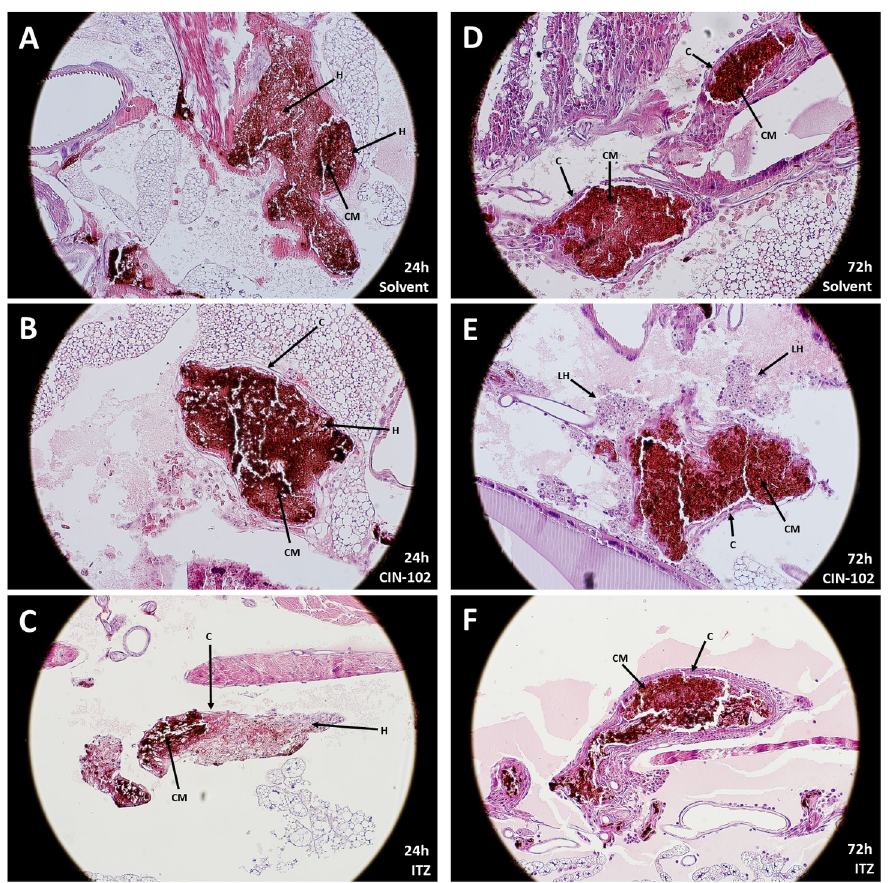
Fig 4. M . mycetomatis grains in Galleria mellonella larvae, 200x magnification. A: M . mycetomatis grain 24h after infection and treated with solvent. Cement material (CM) is present. No clear capsule is formed surrounding this grain. Some individual hemocytes (H) are present in the cement material. B: M . mycetomatis grain 24h after infection and treated with 80mg/kg CIN-102. Cement material is present. A capsule (C) is surrounding the grain, individual hemocytes are found in the grain. C: M . mycetomatis grain 24h after infection and treated with 5.71 mg/kg itraconazole (ITZ). Partial formation of cement material and encapsulation of the grain are observed. Individual hemocytes (H) are present in the cement material. D: M . mycetomatis grain 72h after infection and treated with solvent. Dense cement material seen, no individual hemocytes inside the grain. A capsule is surrounding the grain. E: M . mycetomatis grain 72h after infection and treated with 80mg/kg CIN-102. Cement material is less dense compared to the control (panel C). Capsule is surrounding the grain. Some large hemocytes (LH) are seen surrounding the grain and is not seen in solvent or itraconazole treated larvae. F: M . mycetomatis grain 72h after infection and treated with 5.71 mg/kg itraconazole (ITZ). Both cement material (CM) and encapsulation (C) of the grain are observed. A concentration of 100 μ g/mL to 500 μ g/mL (determined by microdilution) and 40 μ g/mL to 138 μ g/mL (determined by disc diffusion and gradient plate method) was sufficient for the inhibition of Candida spp. and Aspergillus spp. growth, respectively [25–27]. CIN-102 was able to prolong larval survival in M . mycetomatis infected larvae. Within these